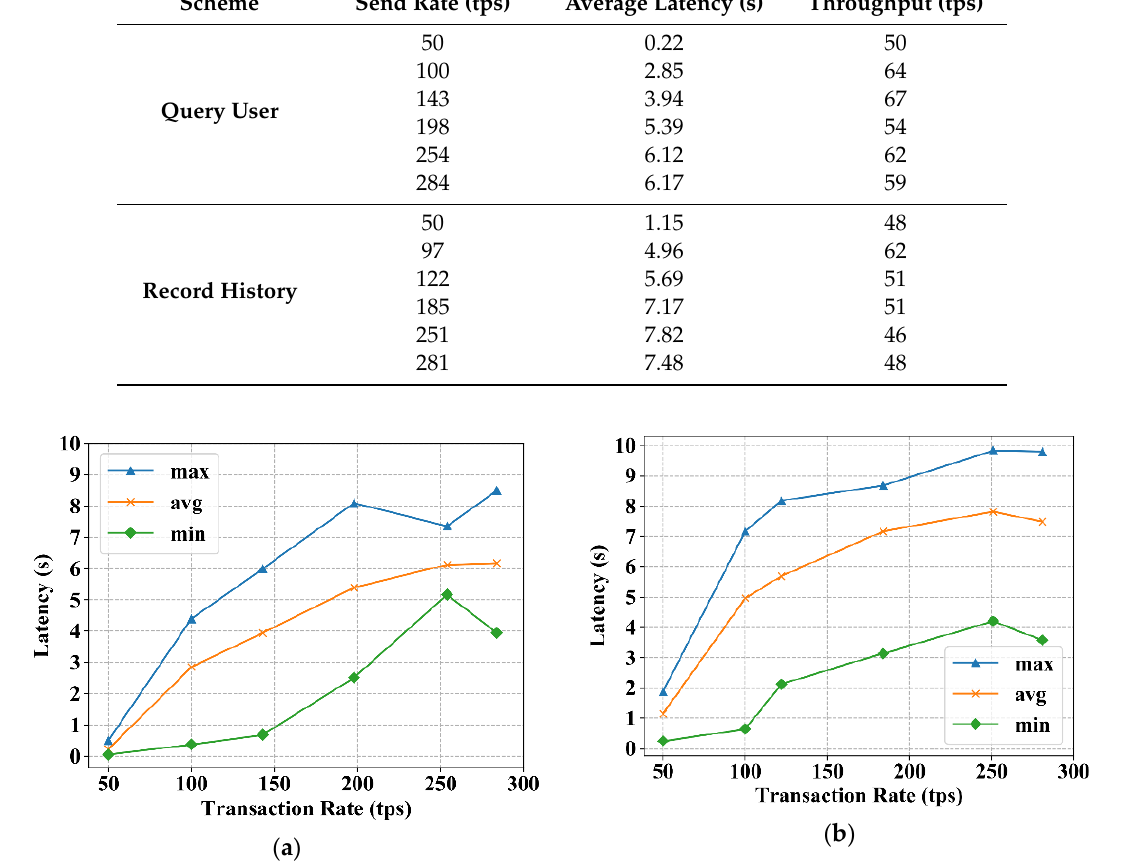
Figure 9. The result of two functions in the chaincode representing latency versus transaction rate: ( a ) query the chaincode to get information; ( b ) invoke the chaincode to record information.